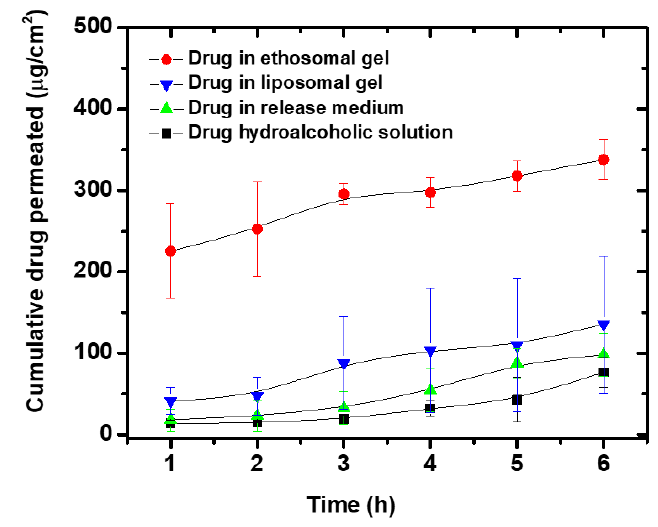
Figure 5. Ex vivo permeation profiles of anthralin from different preparations through rat abdominal Figure5. Exvivopermeationprofilesofanthralinfromdi ff skin.